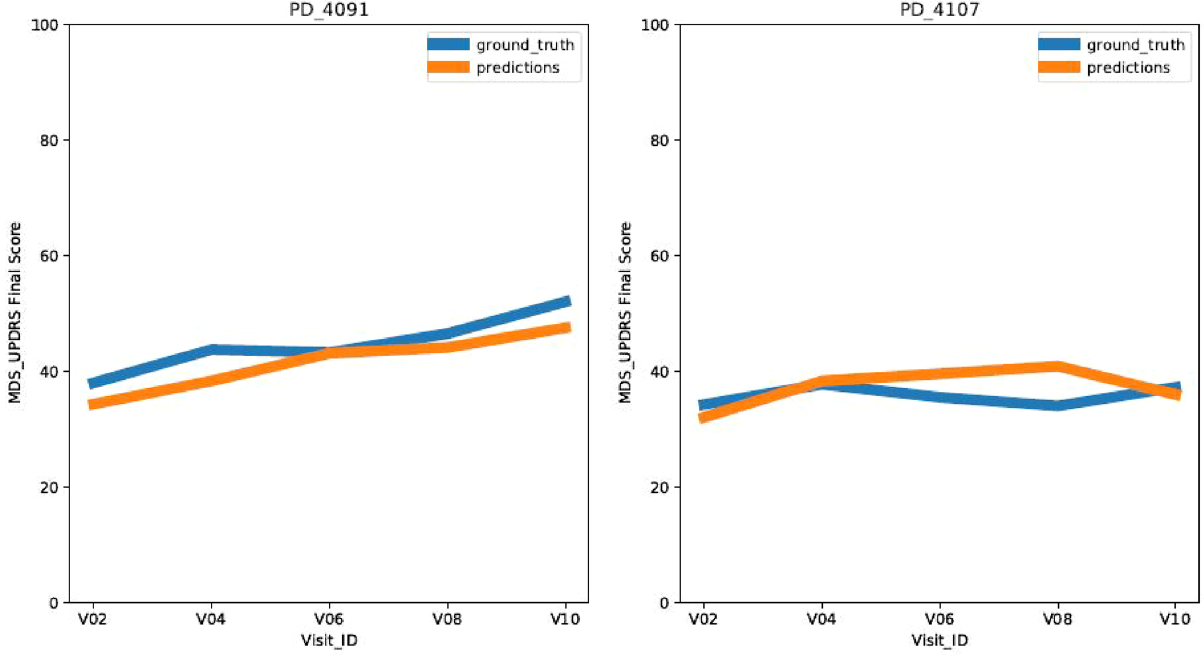
Figure 6. Predicted and Ground Truth disease progression curves for Test Patients. Each subplot belongs to one test patient. The curve in blue is the ground truth curve and the curve in orange is the one predicted by our Predictive Model. The x-axis has discrete visit points of 6 months(V02), 12 months (V04), 24 months (V06), 36 months (V08), 48 months (V10) and the y-axis has the MDS-UPDRS score for the patient.